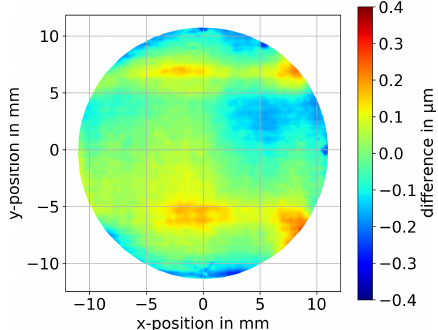
Figure 12. Difference between the two determined deviations from the model with the proposed method (shown in Fig. 11c) and the CT 300 (shown in Fig.